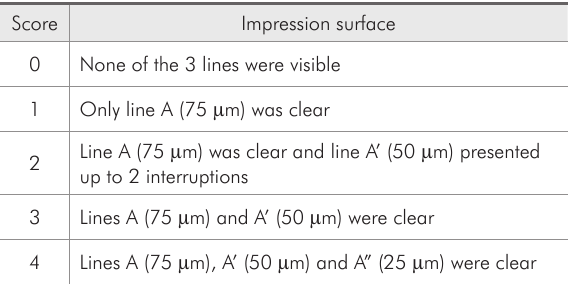
Table.1.- Surface detail index to evaluate the impression surface.